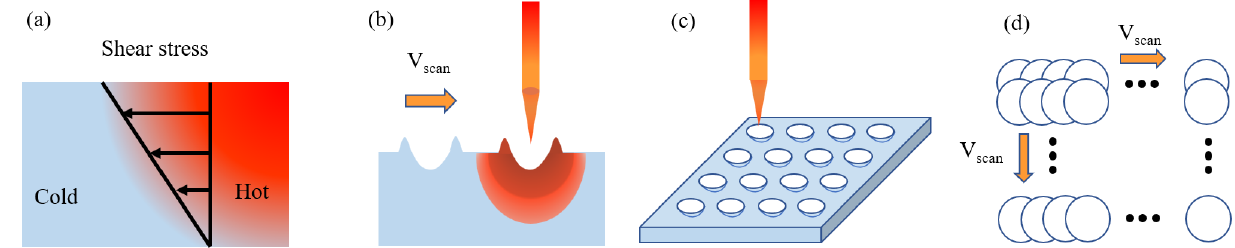
Figure 1. Schematic diagram of the Marangoni effect and laser processing dot matrix structure. ( a ) Marangoni convection; ( b ) Marangoni effect in laser processing; ( c ) laser processing method; ( d ) laser scanning dot matrix.